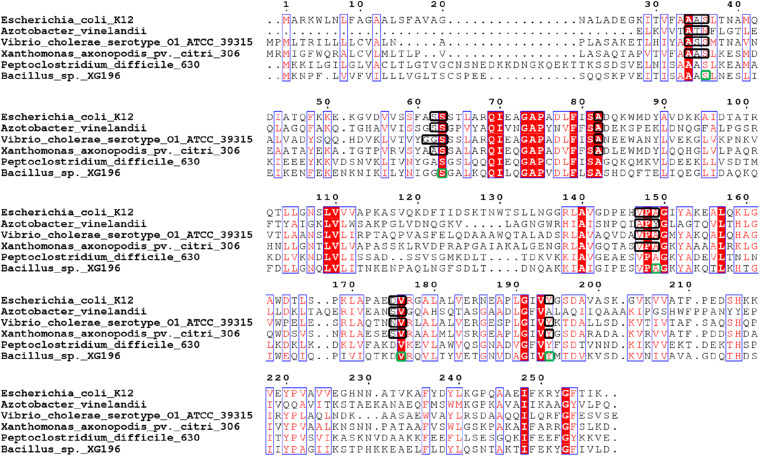
Multi-alignment analysis of Peptoclostridium difficile 630 (ModA, UniProt Entry: Q18A64, PDB: 4KD5), Xanthomonas axonopodis pv. citri 306 (ModA, UniProt Entry: Q8PHA1, PDB: 2H5Y, MoO42-), Escherichia coli K12 (ModA, UniProt Entry: P37329, PDB: 1AMF, MoO42-), Vibrio cholerae serotype O1 ATCC 39315 (ModA, UniProt Entry: Q9KLL7, PDB:4RXL, WO42-), Azotobacter vinelandii (ModA, UniProt Entry: Q7SIH2, PDB: 1ATG, WO42-) and Bacillus sp. XG196. Identical residues are in white and boxed in red, while similar residues are in red and boxed in blue. Molybdate/tungstate binding residues of ModA proteins resolved by crystal structures were indicated in black squares. Molybdate binding residues of XG196 ModA identified by protein modeling using X. axonopodis pv. citri 306 ModA (PDB: 2H5Y) are indicated in green squares.